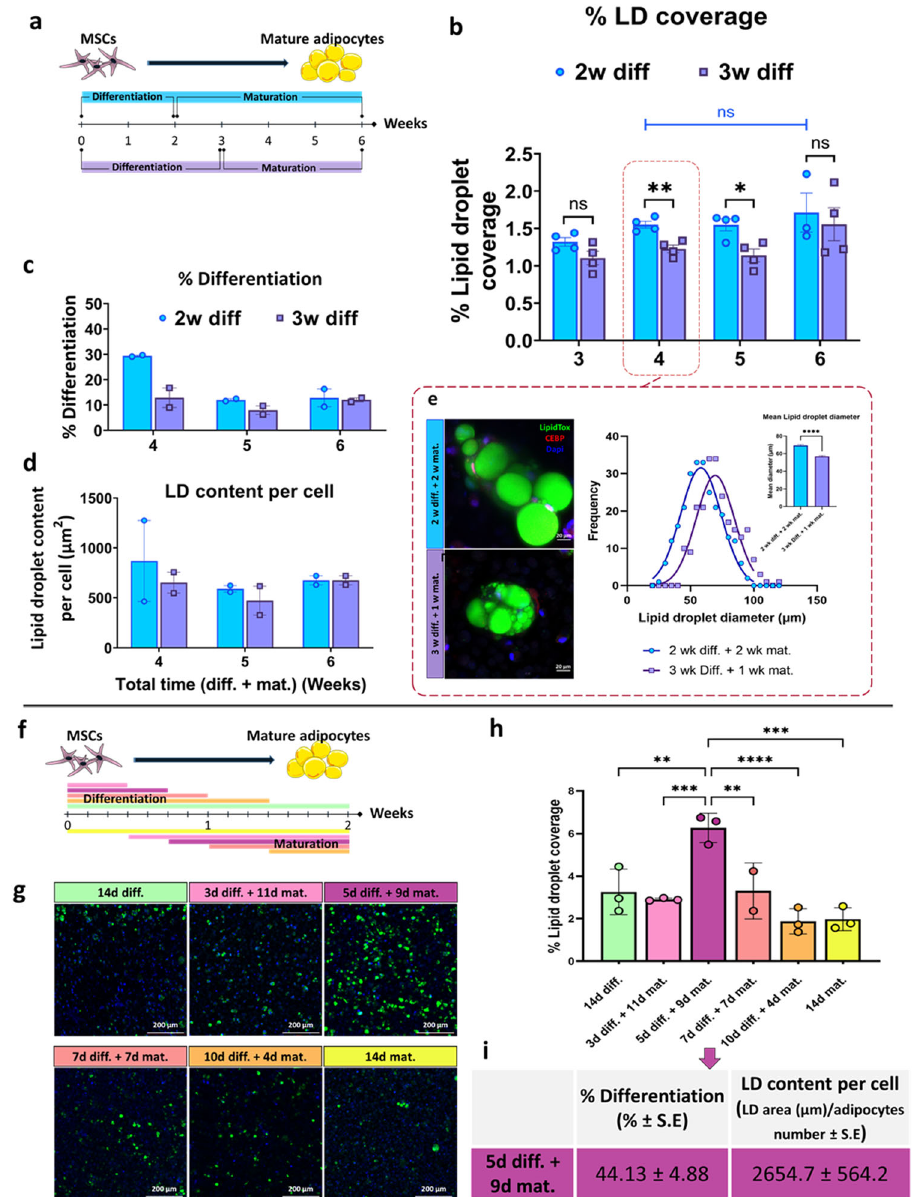
Fig. 3 Optimization of adipogenic differentiation and maturation periods of BMSC-loaded alginate 3D constructs. a Scheme of the 6-week experimental timeline. Image credits: this fi gure was created using elements from Servier Medical Art (https://smart.servier.com ) . b Percentage of lipid droplet coverage, c differentiation percentage, and d lipid droplet content per differentiated cell, in BMSCs subjected to 2 weeks of differentiation followed by 1 – 4 weeks of maturation (blue circles) or to 3 weeks of differentiation followed by 2 – 3 weeks of maturation (purple squares); n = 4. Multiple unpaired t - test, Holm-Sidak post hoc, error bars show standard error (SE), ns: non-signi fi cant, * p < 0.05, ** p < 0.01. e Whole-mount C/EBP α and lipid staining (red, C/ EBP α ; green, LipidTox; blue, DAPI), lipid droplet size distribution and mean diameter after 2 weeks of differentiation followed by 2 weeks of maturation (blue, ‘ 2w diff. + 2w mat. ’ ) and after 3 weeks of differentiation followed by 1 week of maturation (purple, ‘ 3w diff. + 1w mat. ’ ); Student ’ s t -test, error bars show SE, **** p < 0.0001. f Scheme of the 2-week experimental timeline, each color line represents a different experimental timeline. g Whole-mount lipid staining (green, LipidTox; blue, DAPI) and h lipid droplet coverage percentage of lipid-stained constructs subjected to different differentiation/maturation schedules, n = 4, one-way ANOVA followed by Tukey ’ s post hoc test, ** p < 0.01, *** p < 0.001, **** p < 0.0001, error bars show SE. i Mean (±SE) differentiation percentage and lipid droplet content per cell in lipid-stained BMSC-loaded constructs after 5 days in differentiation medium followed by 9 days in maturation medium, n = 3. Each color represents unique combination of differentiation and maturation periods as speci fi ed in the fi gure; d = days; diff. = differentiation medium; mat. = maturation mold (Fig. 4a). To further prove the differentiation of the satellite cells into muscle cells, confocal laser scanning microscope (LSM) integrated, without detachment points after 1 week of co-culture images of samples stained for myogenin, a muscle-speci fi c tran- (Fig. 4a and Fig. S4a). Desmin-stained myotubes alongside mature scription factor involved in myogenesis, were taken from the areas adipocytes took on the ring and semicircular con fi gurations of the of the muscle in the integrated constructs (Supplementary, Fig. S4b).